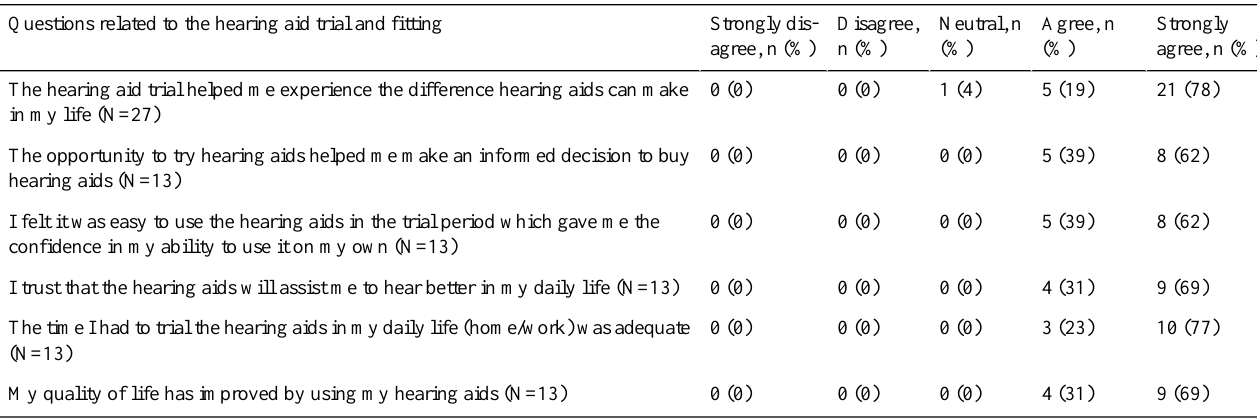
Table 4. Patient evaluation of the hearing aid trial and fitting.